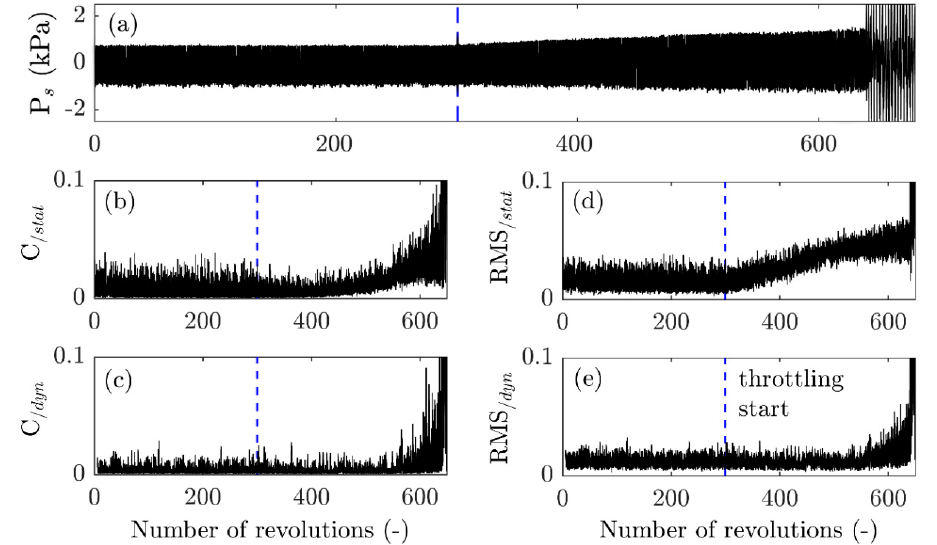
Figure 8. Evolution of the surveillance parameters during a throttling process. ( a ) Time evolution of pressure; ( b ) Correlation—Static reference profile; ( c ) Correlation—dynamic reference profile; ( d ) RMS—Static reference profile; ( e ) RMS—dynamic reference profile. Sensor location: (x, θ ) = ( − 0.06.C x , 90 ◦ ); moderate throttling speed.